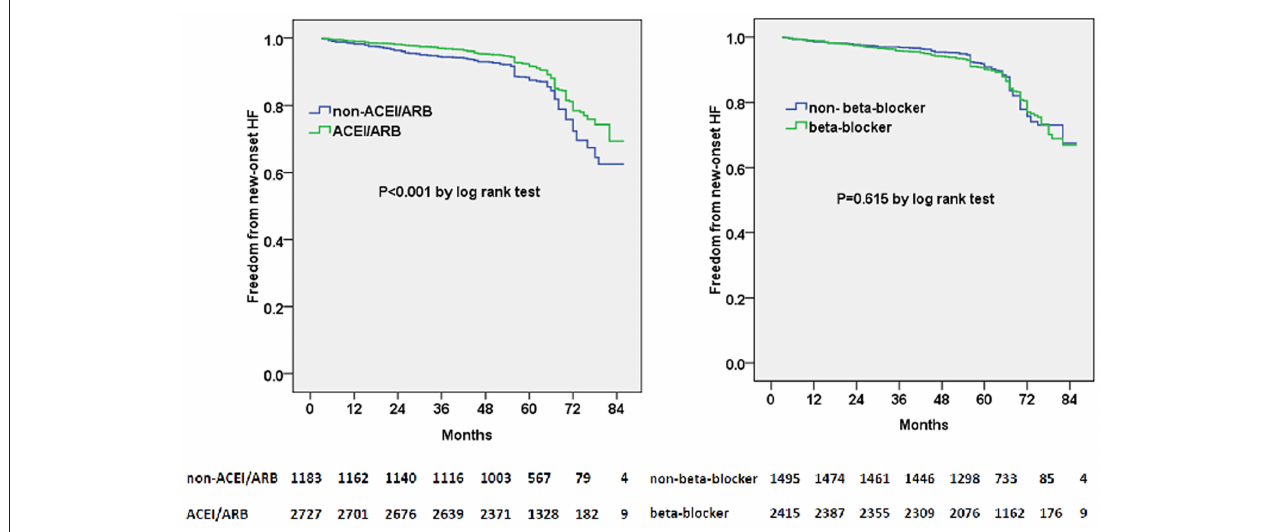
FIGURE 1 | Kaplan–Meier curves of freedom from new-onset HF for different medical treatment. The numbers at the bottom of the figure are “number at risk”.